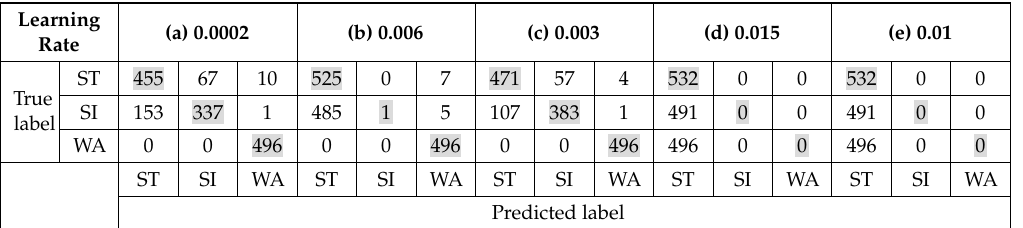
Table 11. Confusion matrices: (OR + LA1).